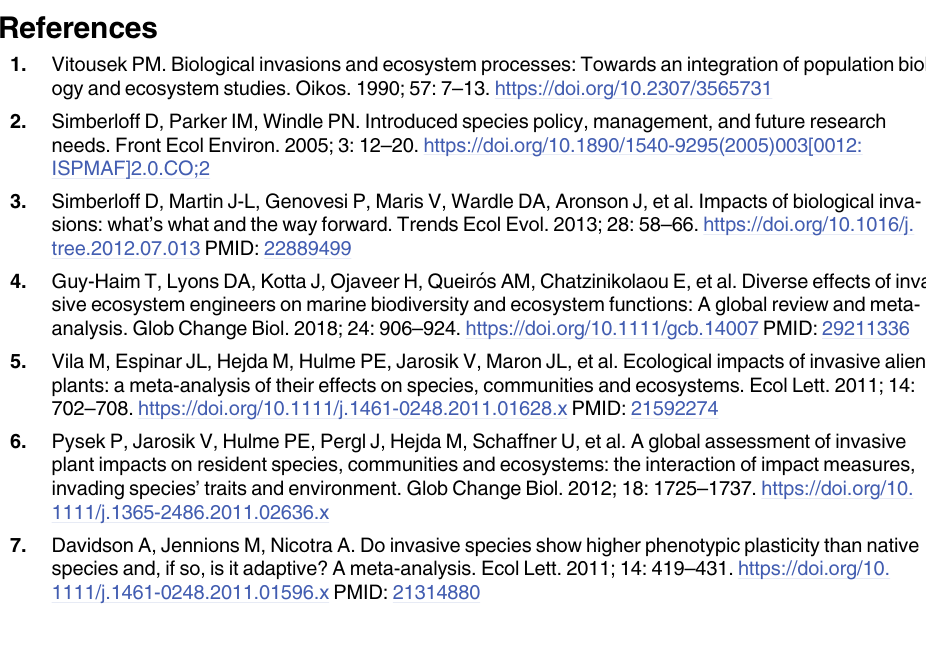
S3 Fig. Two-dimension non-metric multi dimensional scaling (nMDS). The ordination is based on the triangular matrix derived from the Bray-Curtis index measuring differences in native species composition between macroalgal assemblages from control (+S) and S . muticum — removed rock pools (-S) at each of the four sites indicated in the graph. P = Peizas, RB = Rocas Blancas, LG = La Griega and V =